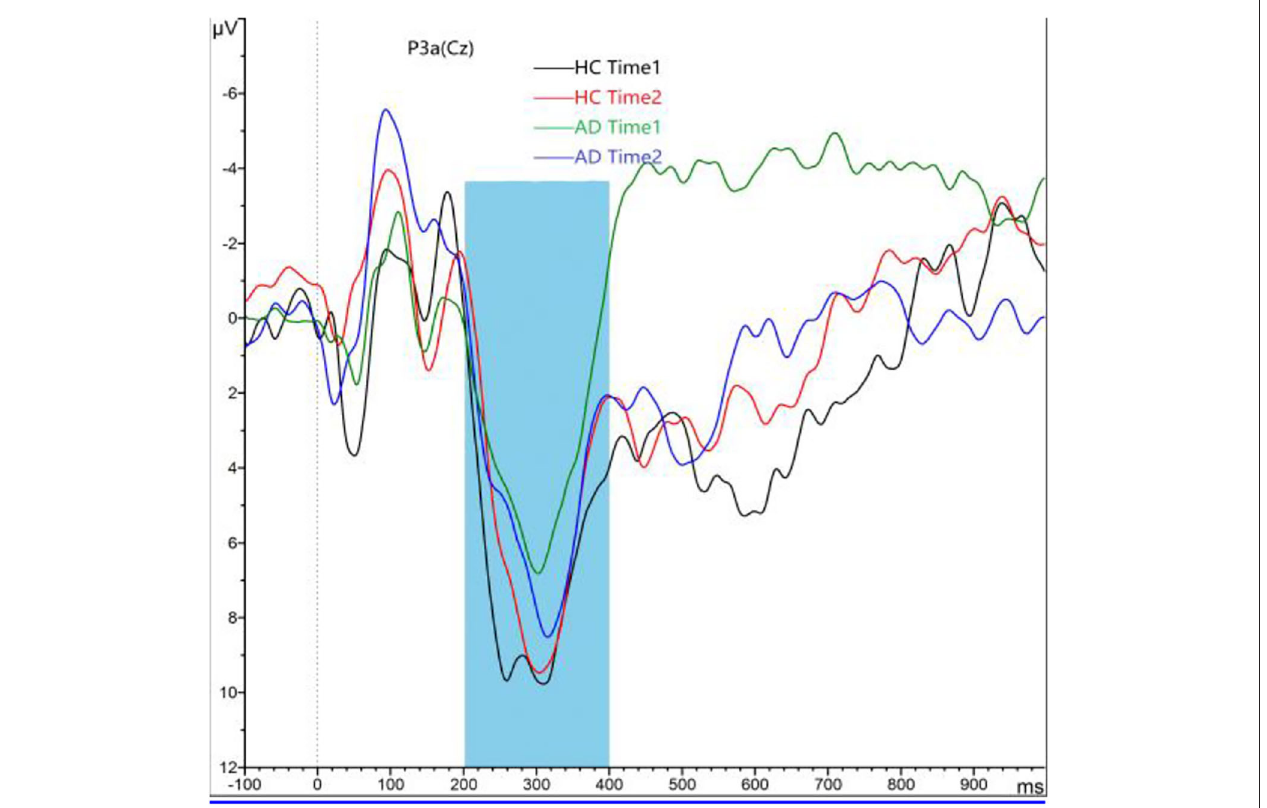
FIGURE 2 | Grand averaged P3a was elicited by a three-stimulus auditory oddball paradigm for the alcohol dependence (AD) group (purple lines and green lines) and the healthy control (HC) group (black lines and red lines) at time 1 and time 2. The P3a was presented within a 250- to 450-ms latency window at the Cz electrode site. The gray area is